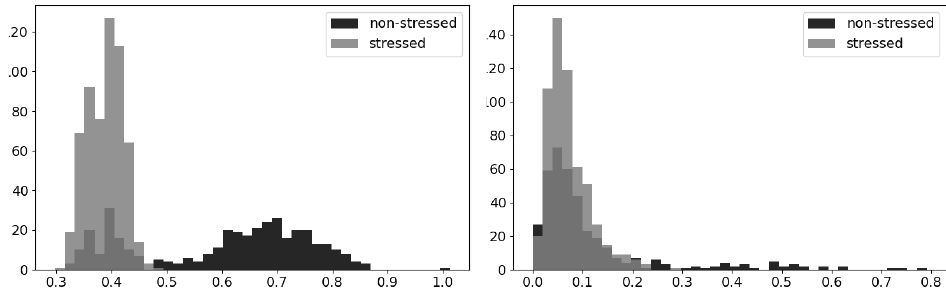
Figure 3. These histograms provide a way to visualize the relationship between each feature and stress and the related validity coefficients. Left : Distributions of the PT mean feature for stressed and nonstressed state; right : distributions of the MCVNN feature for the same two states.